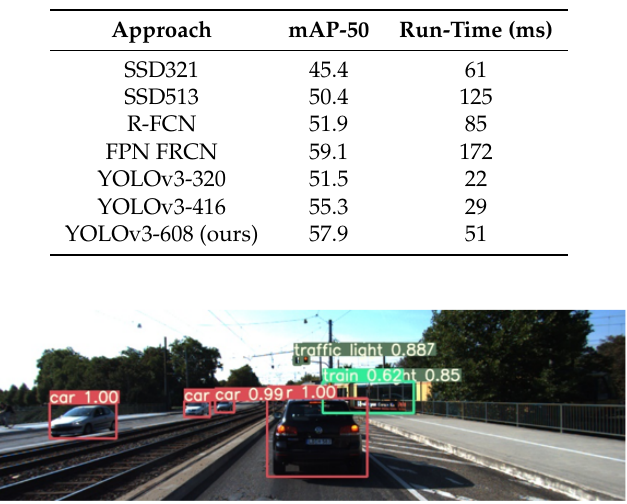
Figure 3. Result of YOLOv3 [2] (Returns the position, class and score of trust of each detected